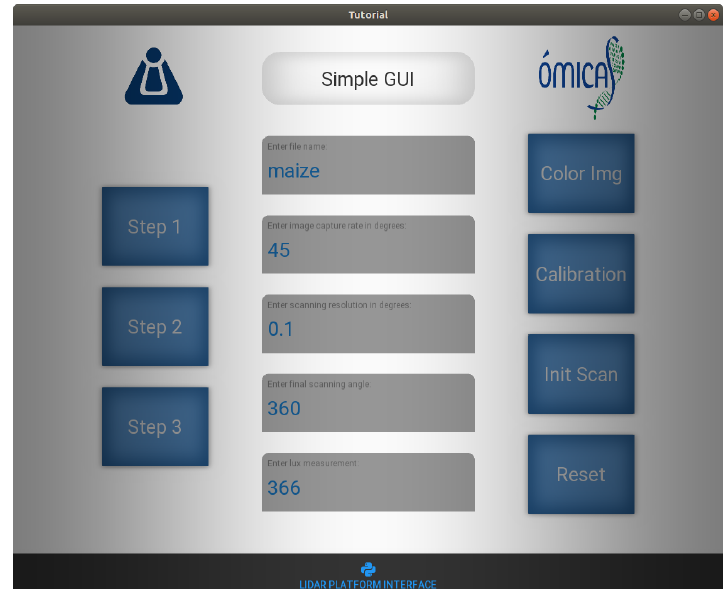
Figure 6. User Interface for LiDAR platform.